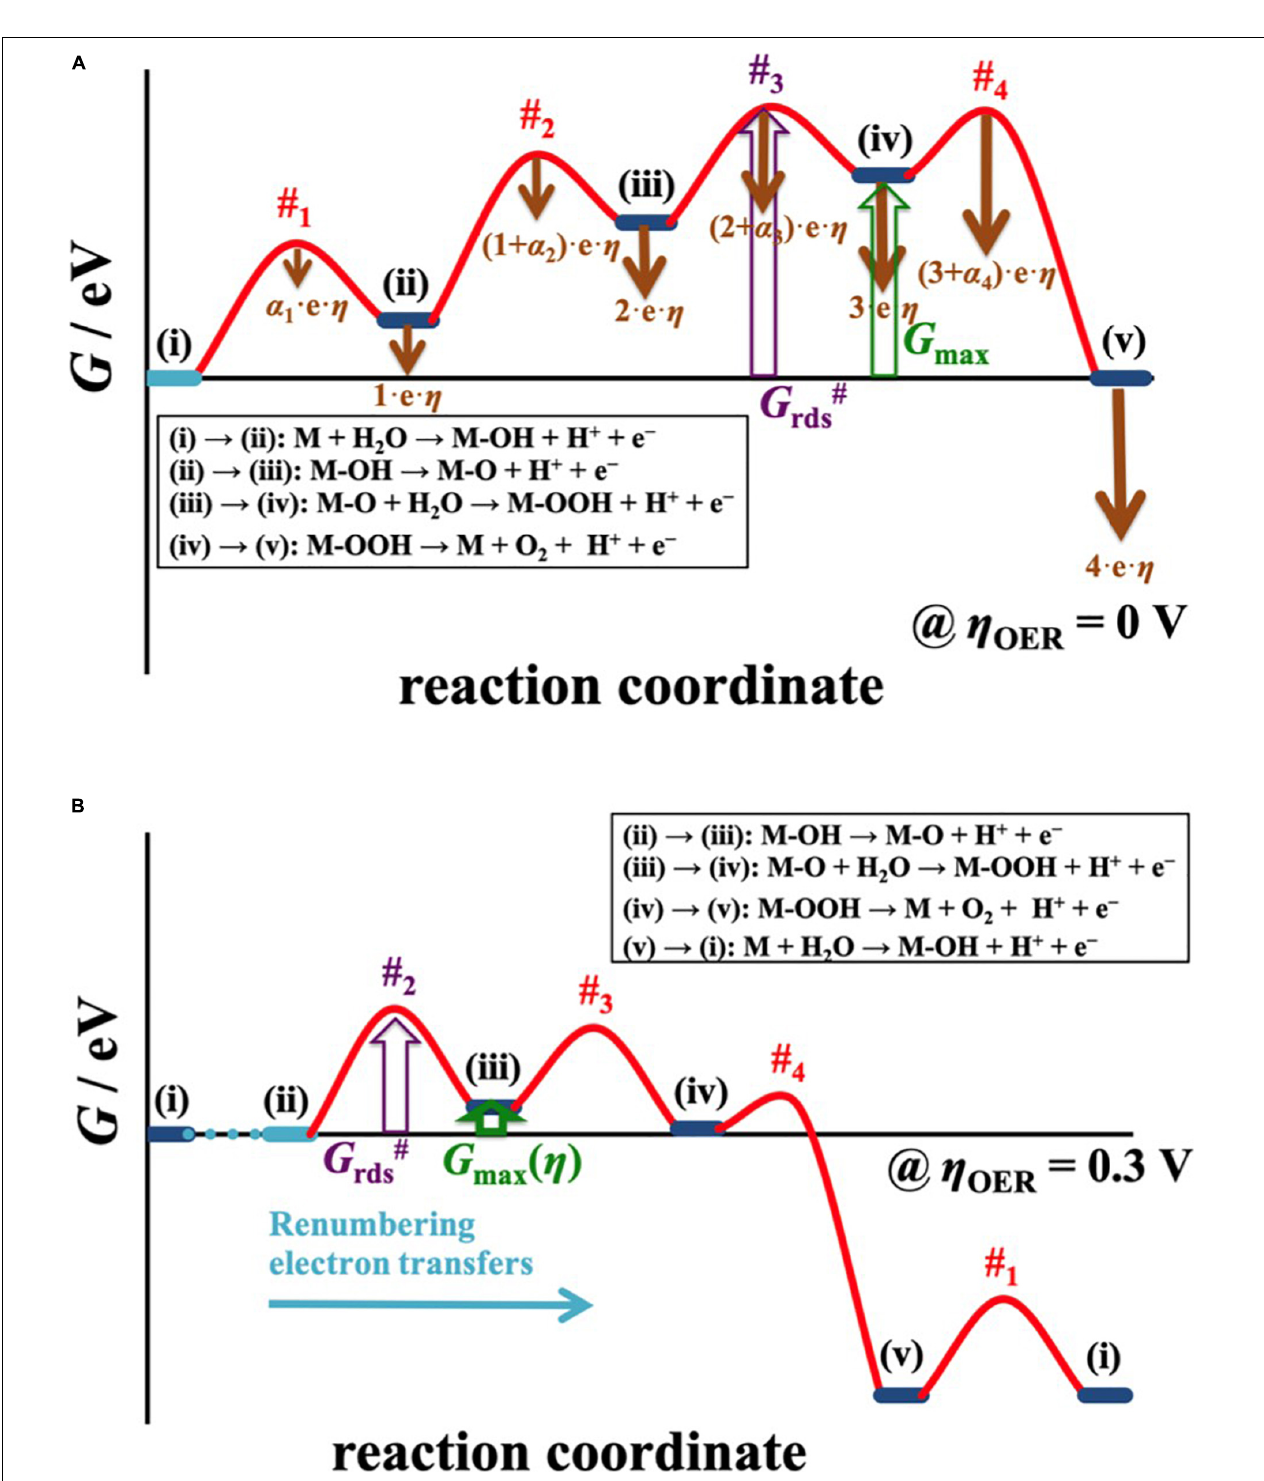
FIGURE 8 | (A) The free-energy span model is applied to determine the distance between the intermediate with smallest free energy and the intermediate with highest free energy in the OER landscape, described by the descriptor G max . By accounting for the overpotential dependency of the elementary reaction steps, indicated by brown arrows in a), the free-energy diagram is translated to an applied overpotential of 300 mV in (B) to evaluate G max ( η ). Herein, the electron-proton transfer steps are renumbered in that the reaction always commences from the intermediate with smallest free energy. The peculiarity of the overpotential-dependent descriptor G max ( η ), albeit of thermodynamic nature, is that this activity measure directly scales with the kinetics of the reaction, which is governed by the transition state with highest free energy ( G rds# ) in the free-energy diagram. Reproduced with permission from Exner (2020g). Copyright 2020 American Chemical Society.